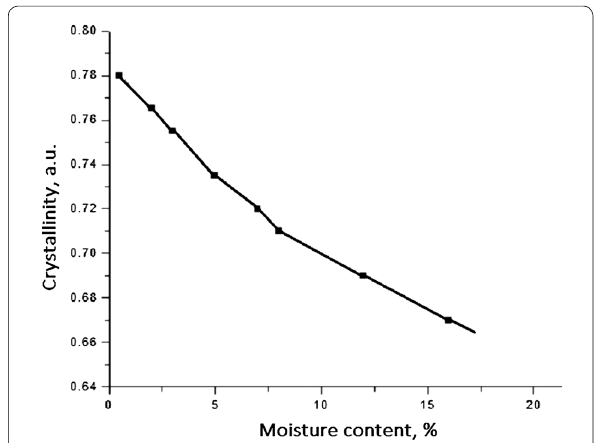
Fig. 4 Dependence the crystallinity of cellulose on its moisture